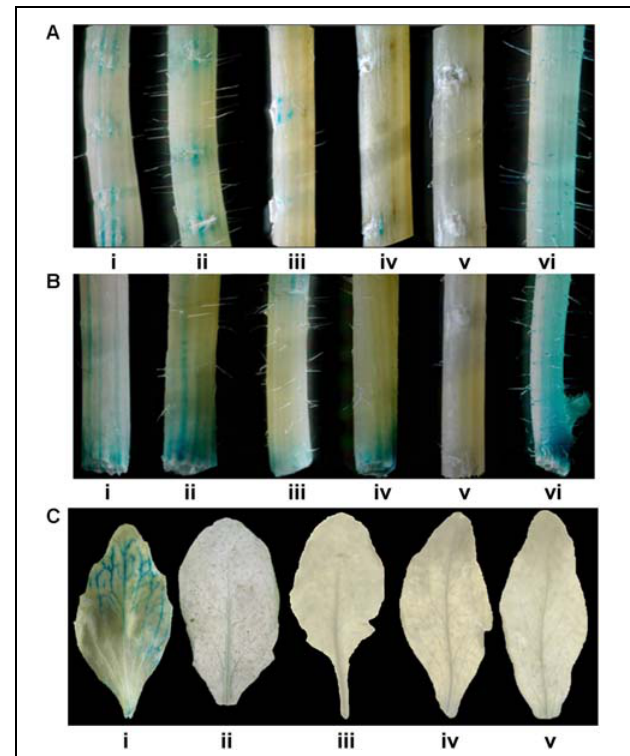
responsiveness of CYP76M7 promoter. Stems of different Arabidopsis plants with (A) surface wounding and (B) wounding at the cut ends of (i) Pcyp2004; (ii) Pcyp1456; (iii) Pcyp1167; (vi) Pcyp520: (v) Pcyp222; (vi) 35S promoter. (C) GUS histochemical assay for the leaves undergoing senescence in different transgenic Arabidopsis plants containing CYP76M7 deletions; (i) Pcyp2004; (ii) Pcyp1456; (iii) Pcyp1167; (iv) Pcyp520: (v)